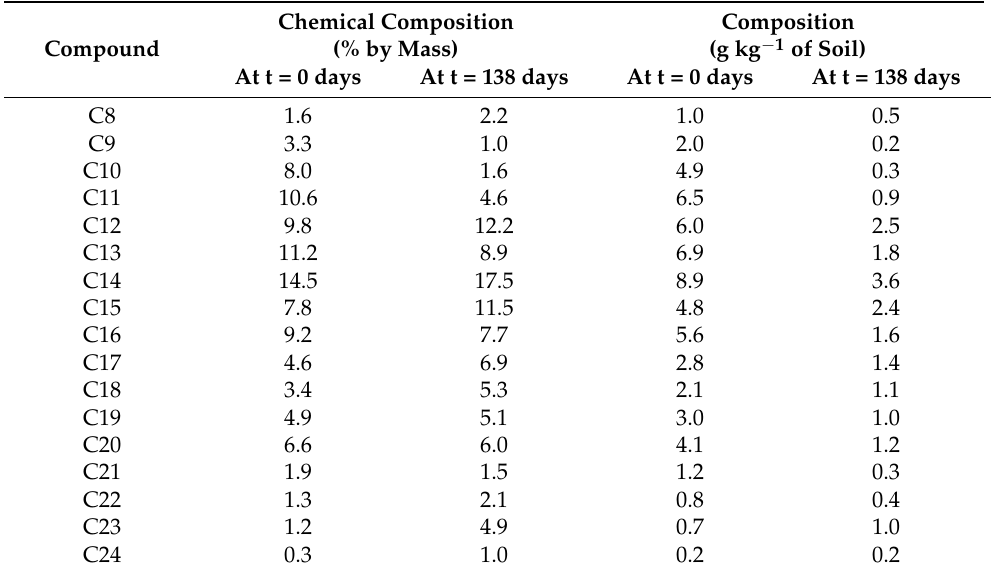
Table 3. Chemical composition (% by mass and g kg − 1 of soil) of diesel oil by number of carbon atoms, at the beginning (t = 0 days) and the end (t = 138 days) of the experimental run. Chemical Compound